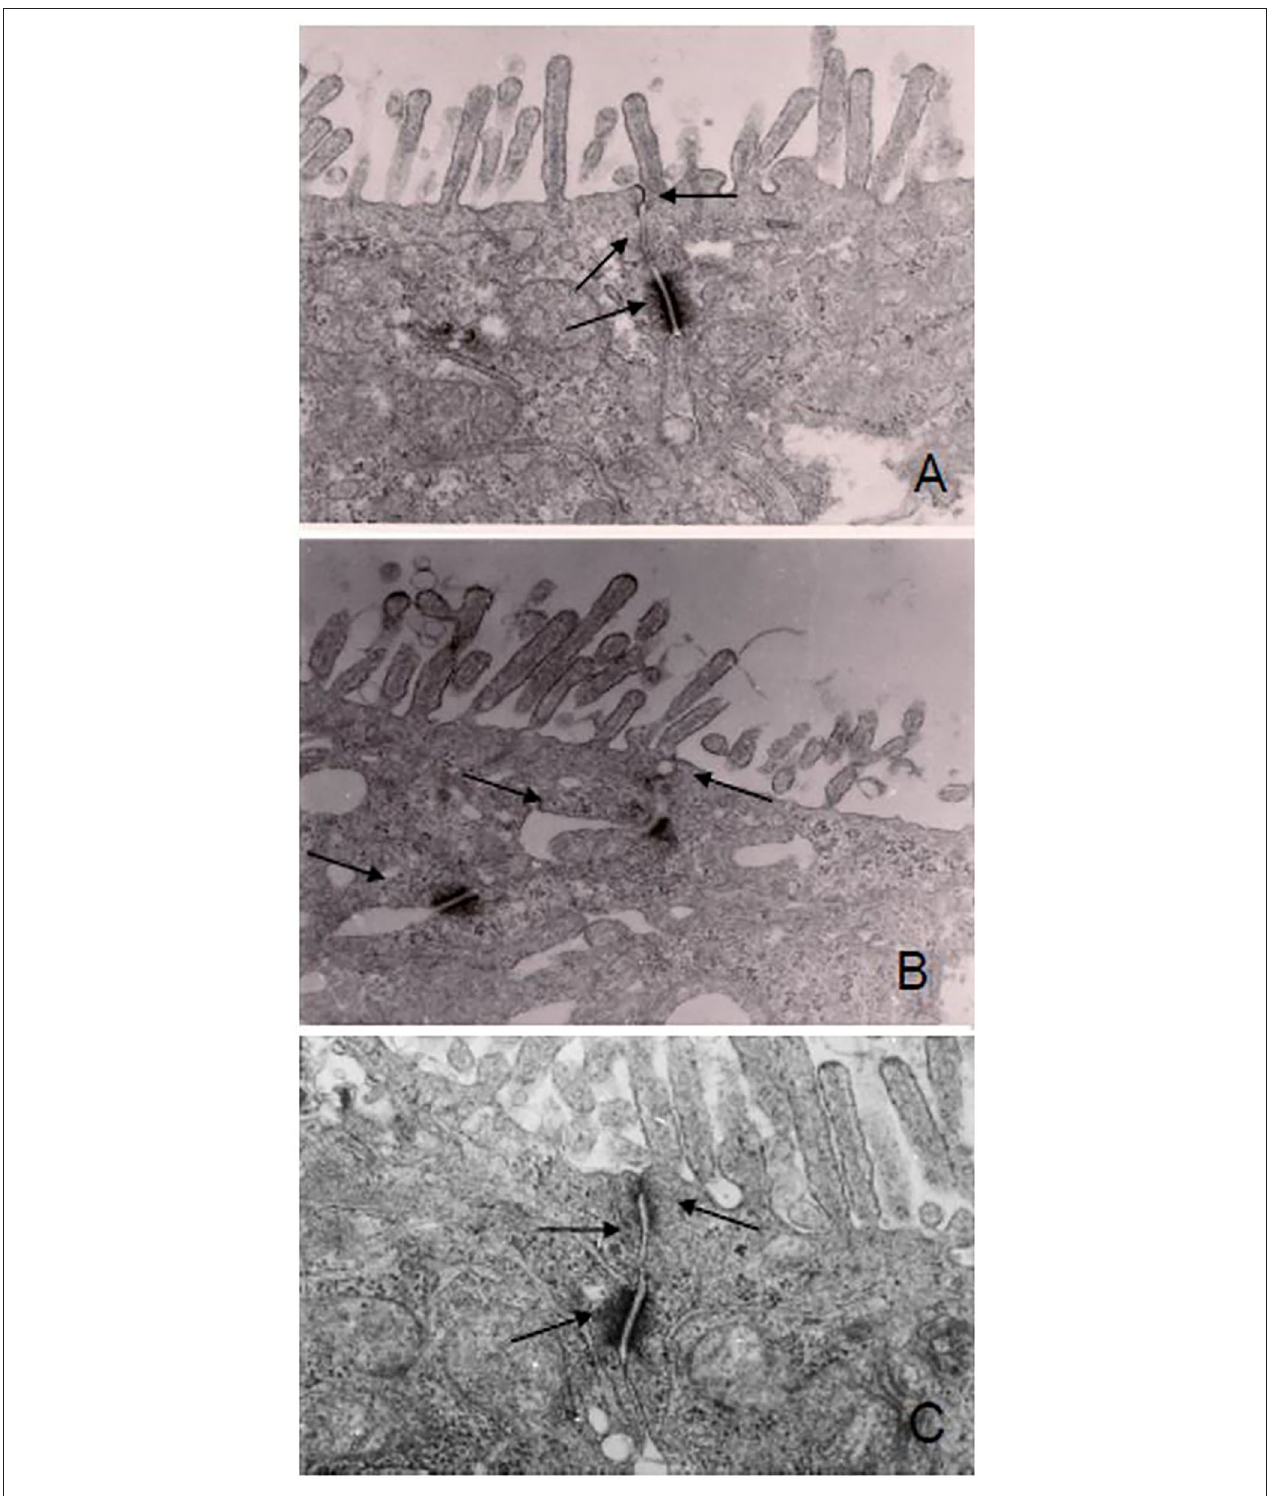
FIGURE 1 | Ganglioside mitigates the disruption of junction complexes in CaCo-2 cells. Cell monolayers were exposed to pro-inflammatory stimulus with or without ganglioside pre-incubation. There was disruption of the tight junctions, adherens junction, and desmosomes in DSS-treated cells (B) compared with control cells (A) or cells pre-incubated with ganglioside (C) . Arrows indicate tight junction, adherens junction and desmosomes. Images were obtained at 2600x magnification on a Hitachi H7000 Transmission Electron Microscope.